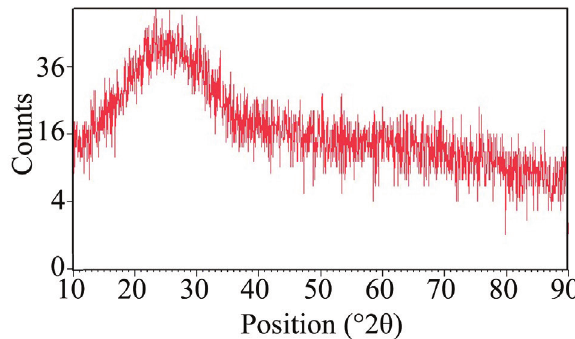
Figure 4: X-ray powder diffraction (XRD) pattern of the synthesized INPs; no characteristic peak was observed which indicates amorphous structure of the nanoparticles.